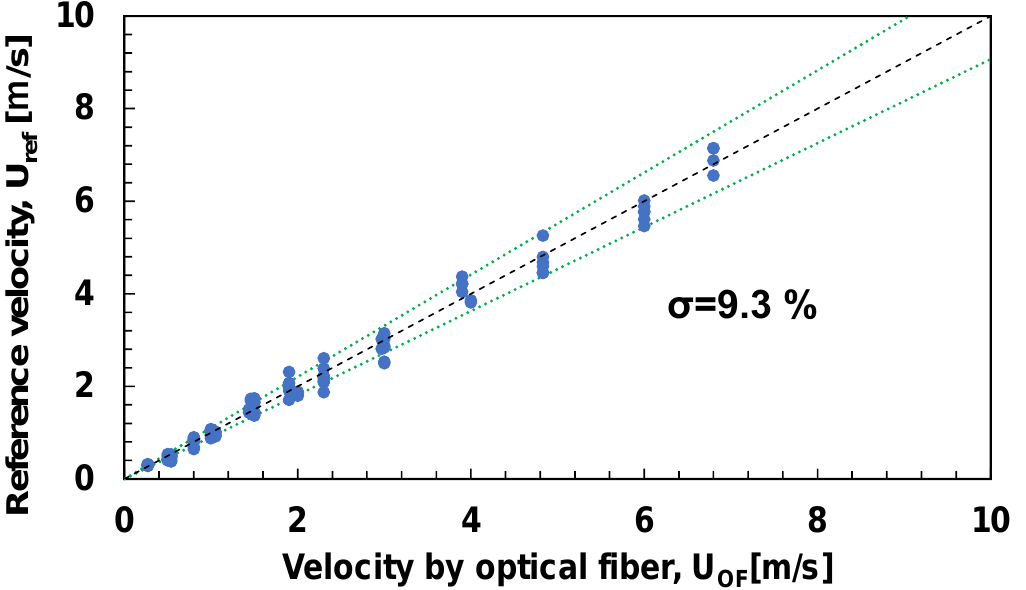
Figure 4. Decay time constant ( 𝜏 ) of temperature transients as a function of reference velocity ( 𝑈 𝑟𝑒𝑓 ).